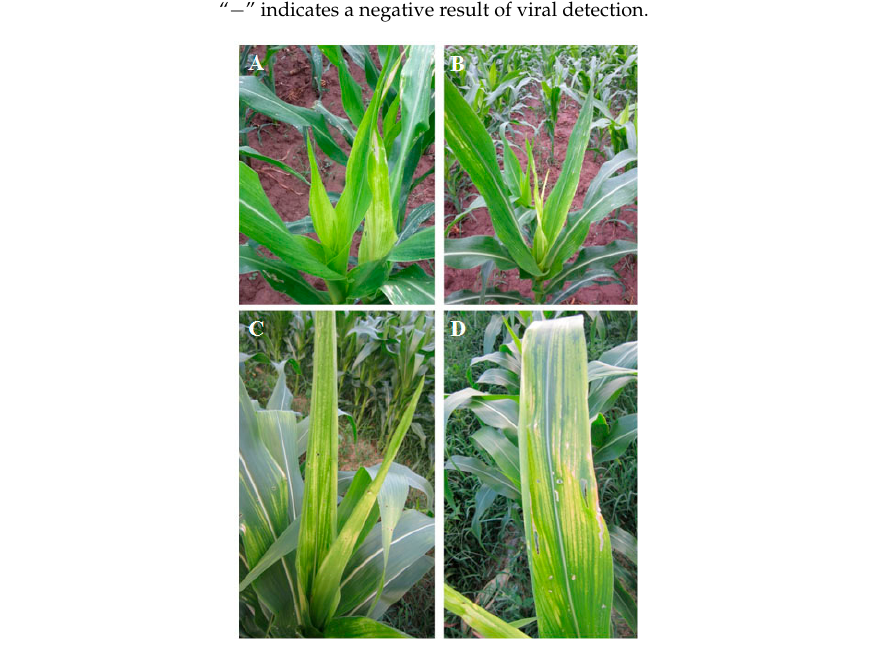
Figure 1. Typical yellow mosaic symptom as represented on the field maizes. Overall view of the whole plants collected from Yuanmou, Yunnan ( A , B ) and Changshun, Guizhou ( C ). ( D ) A closer photograph of a leaf associated with MaYMV.